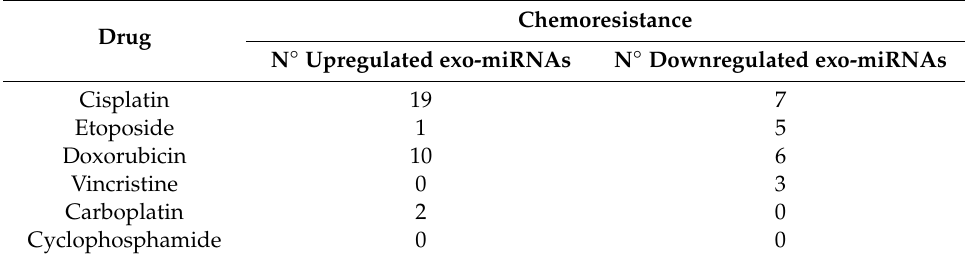
Table 4. Number of exo-miRNAs associated with the response to chemotherapeutic